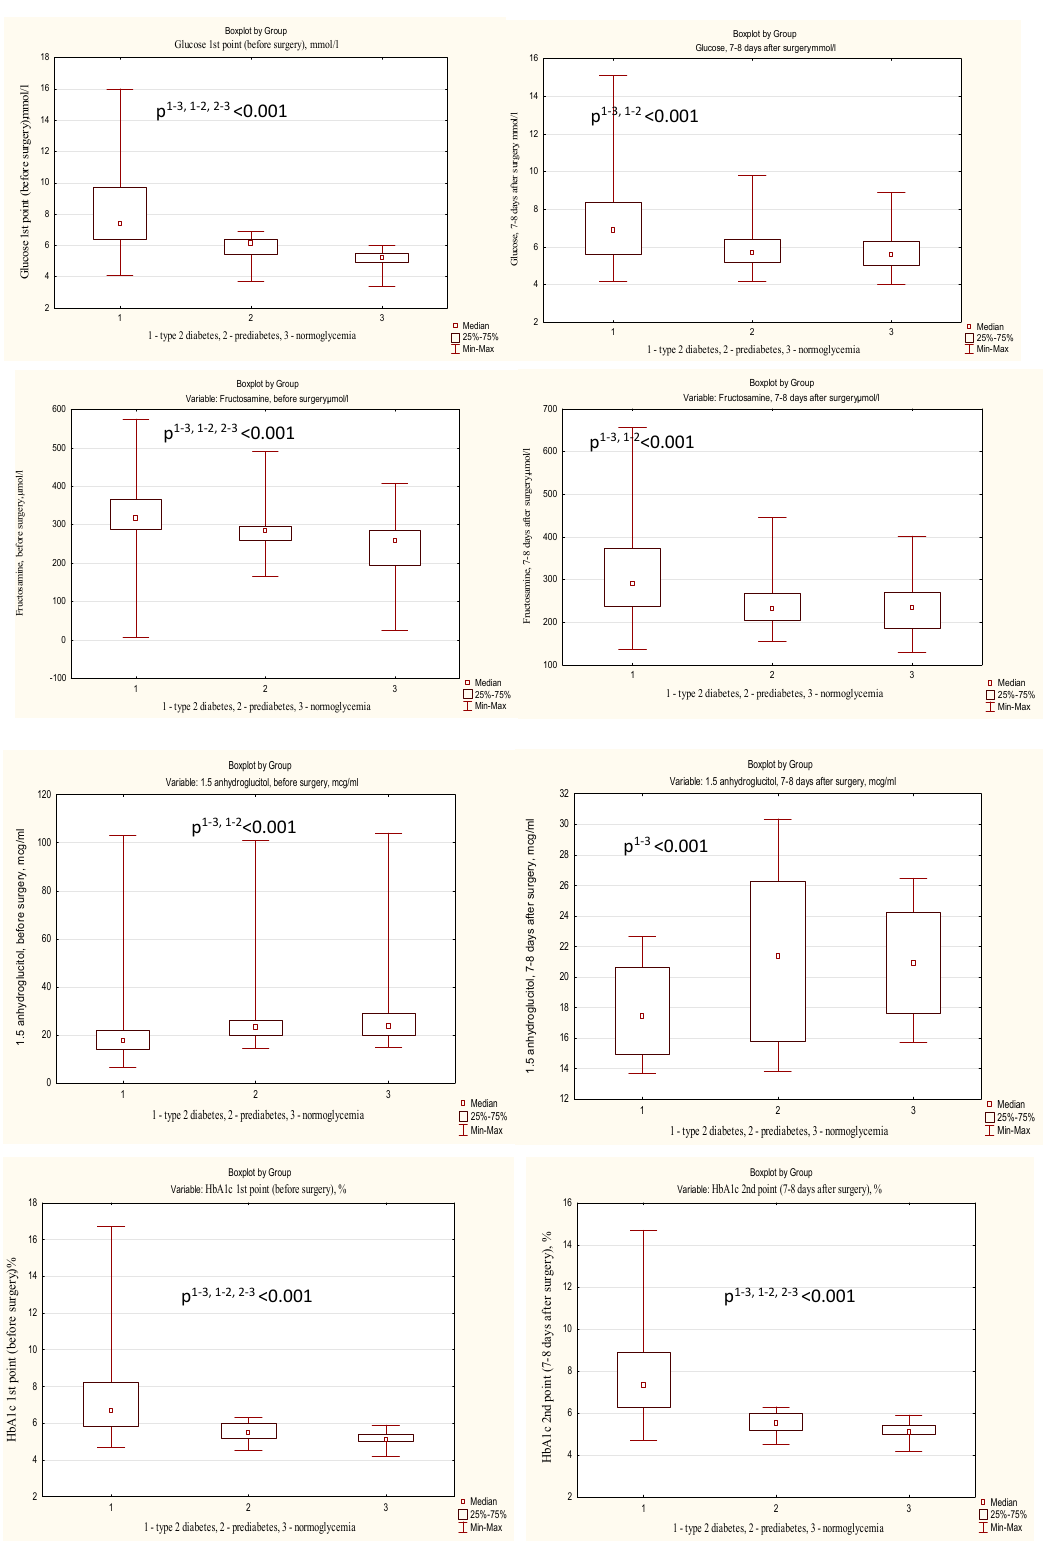
nificant differences in pairwise comparison of groups 1 and 3, #—significant differences in pairwise comparison of groups 2 and 3, $—significant differences in pairwise comparison of groups 1 and 2.